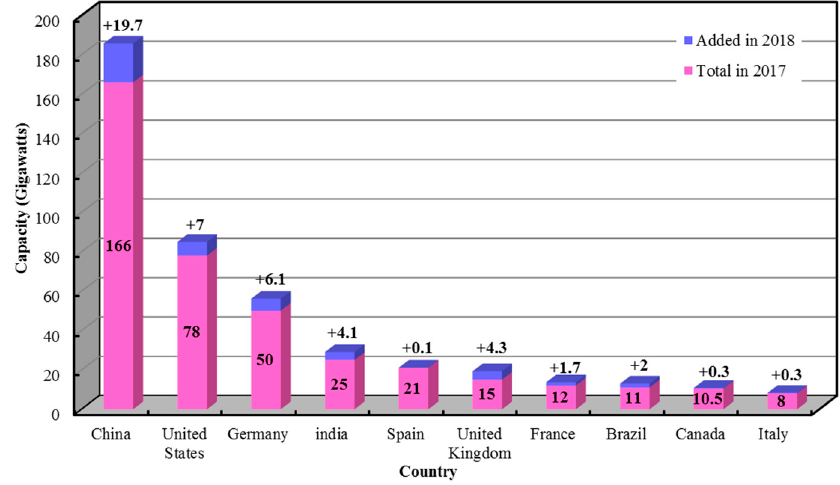
Figure 2. Wind Power Capacity versus Additions, for the Top Ten Countries, 2018.